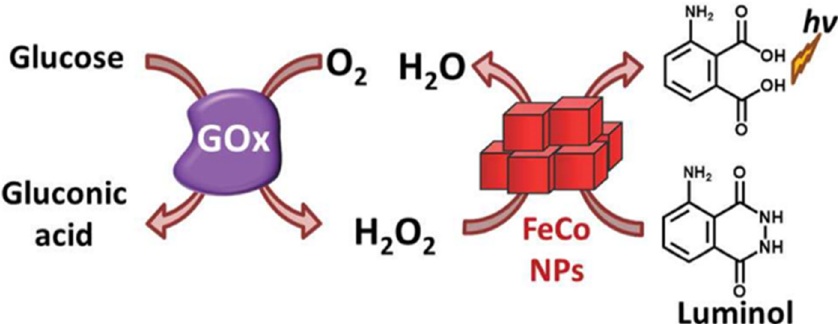
Figure 4. Coupling of the PBFeCo-catalyzed chemiluminescence generation system to the GOx- mediated aerobic oxidation of glucose to gluconic acid and H 2 O 2 for the development of a glucose sensor. Reproduced with permission from [28].